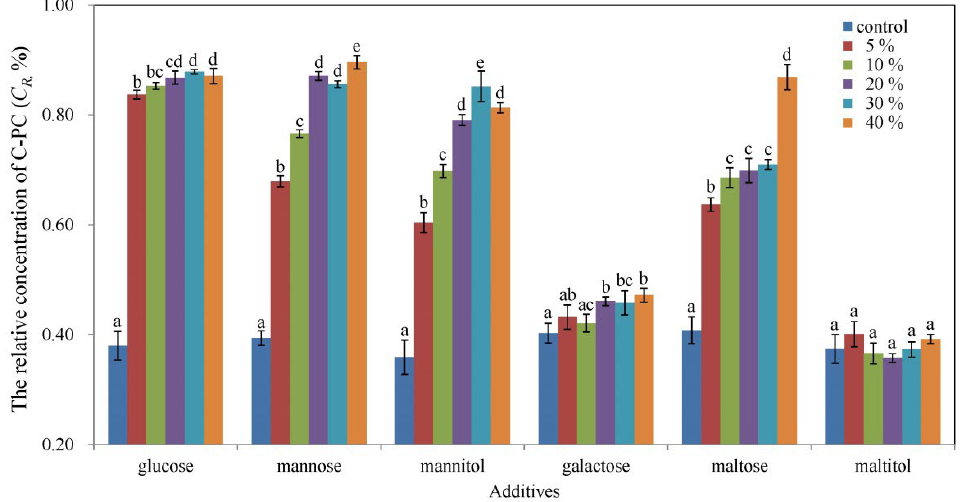
Figure 4. Relative concentration of C-PC treated with 5–40% additives with subsequent exposure to 4.5% H 2 O 2 for 24 h. Data with different letters indicate significant differences ( p < 0.05) between the control and treatments.